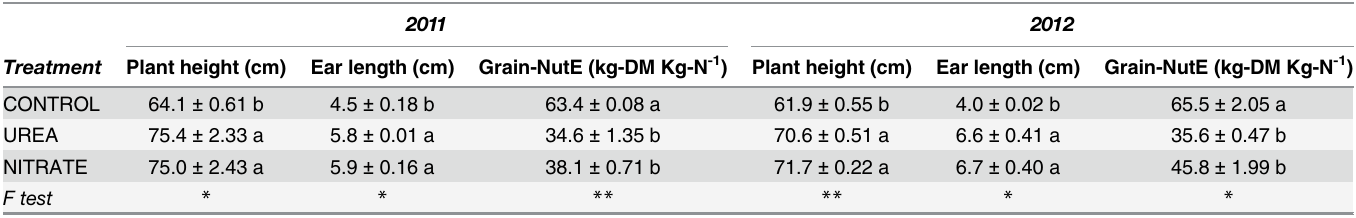
Table 1. Plant height (cm), ear lenght (cm) and grain nitrogen utilization efficiency (grain-NutE; kg- DM kg-N -1 ) as recorded at harvest, in 2011 and 2012. Wheat plants were exposed to control conditions (unfertilized CONTROL) and to two N fertilization treatments with urea (UREA) and calcium nitrate (NITRATE) at the rate of 150 kg N ha -1 . Data are averages ± standard errors, for n = 3 independent replicates. Different letters indicate significant differences at p < 0.05 (Fisher ’ s LSD test).